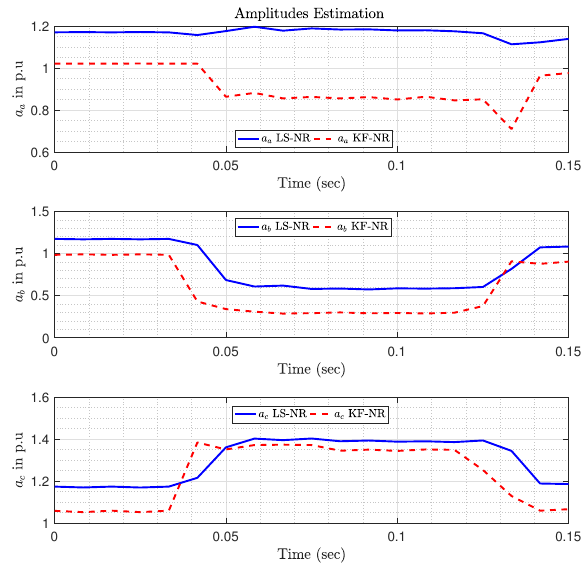
Figure 9. Amplitude variation of phasors: Comparison between LS and KF using NRA estimations (event 2912).